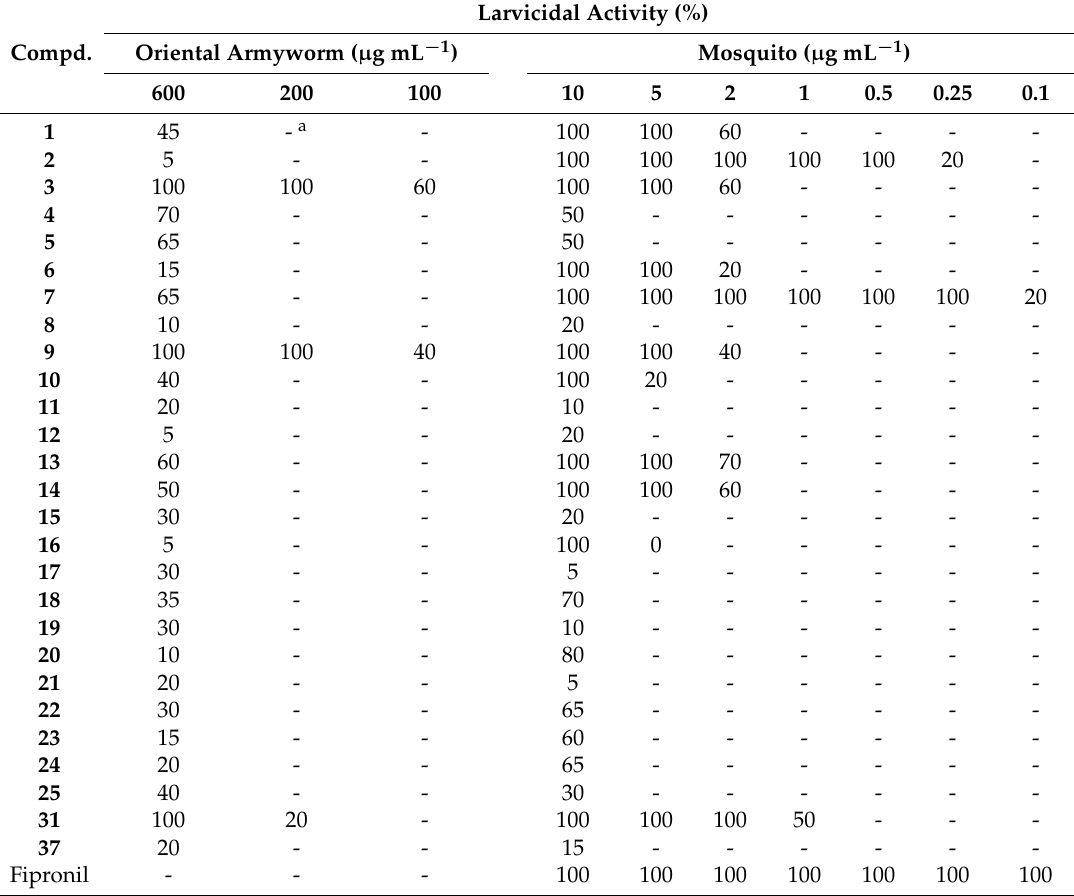
Table 1. Larvicidal Activities against Oriental Armyworm and Mosquito of Compounds 1 – 25 , 31 , 37 .